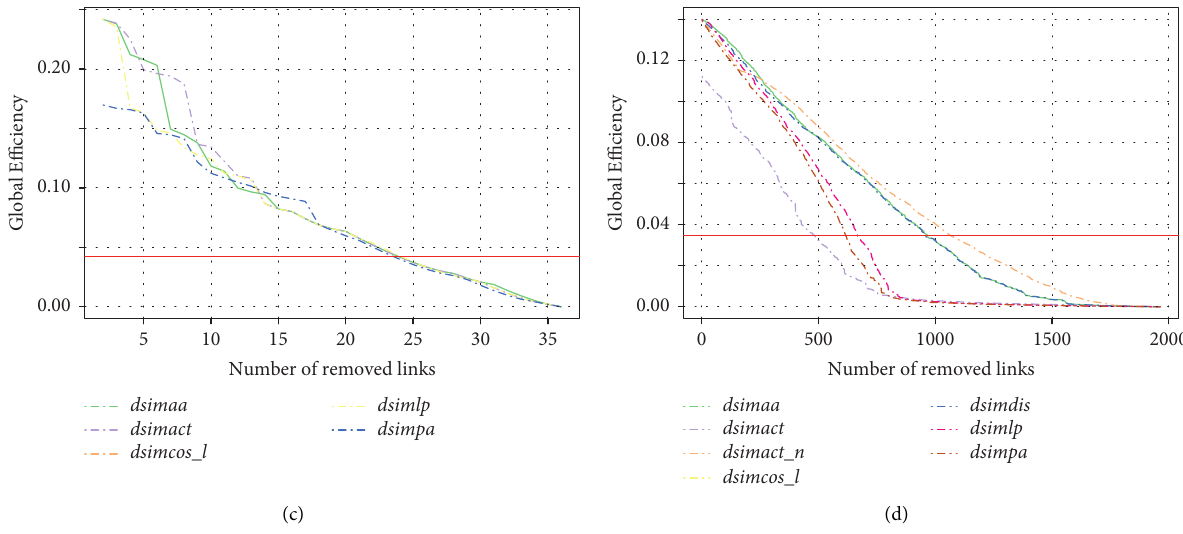
Figure 6: Variation in global efficiency when links with certain similarity characteristics are removed in Metlink (a), PPTC, ROPIT (b), Sage (c), and STAR (d) networks.